Question: Identify the chart type used in this figure.
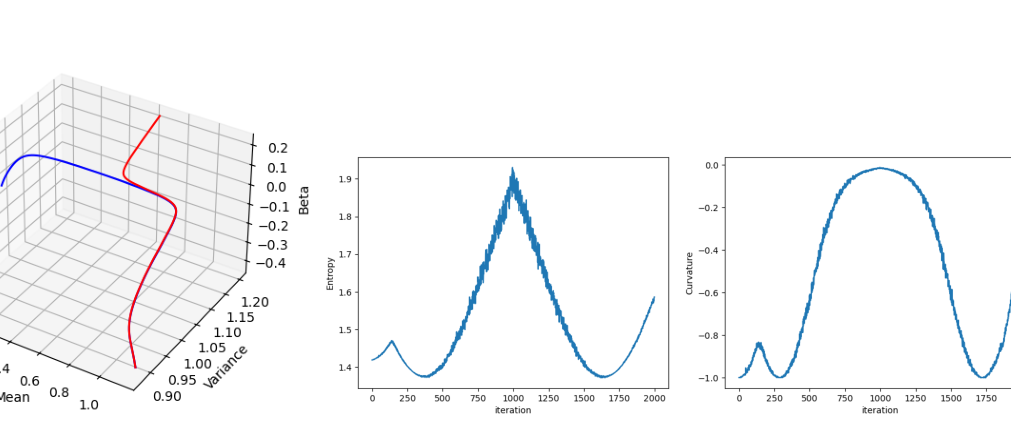
Answer: line